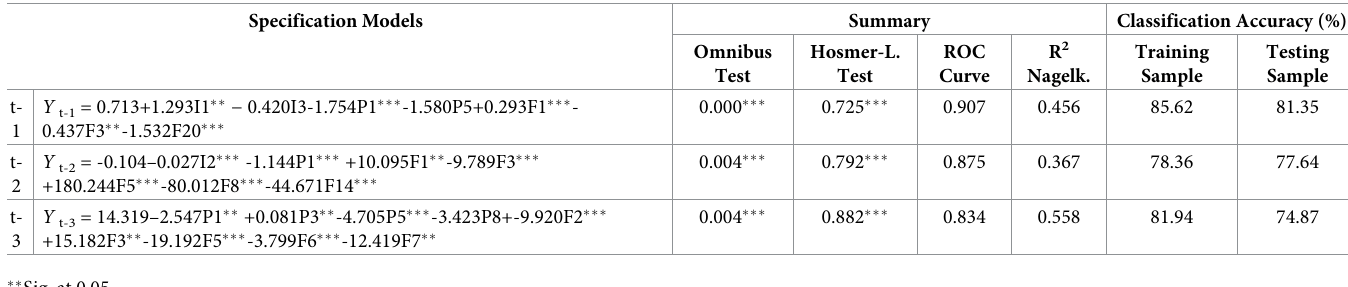
Table 2. Results of the estimated Logit